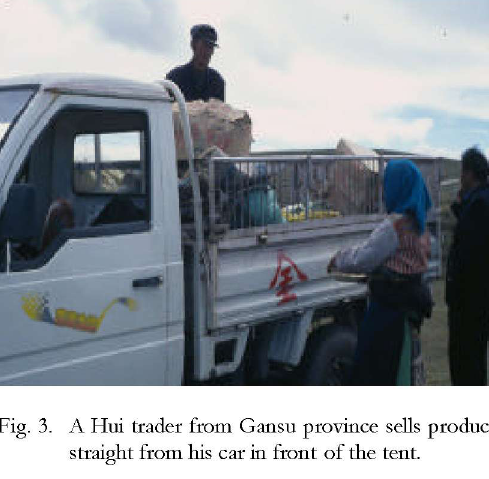
Fig. 3. A Hui trader from Gansu province sells produce straight from his car in front of the